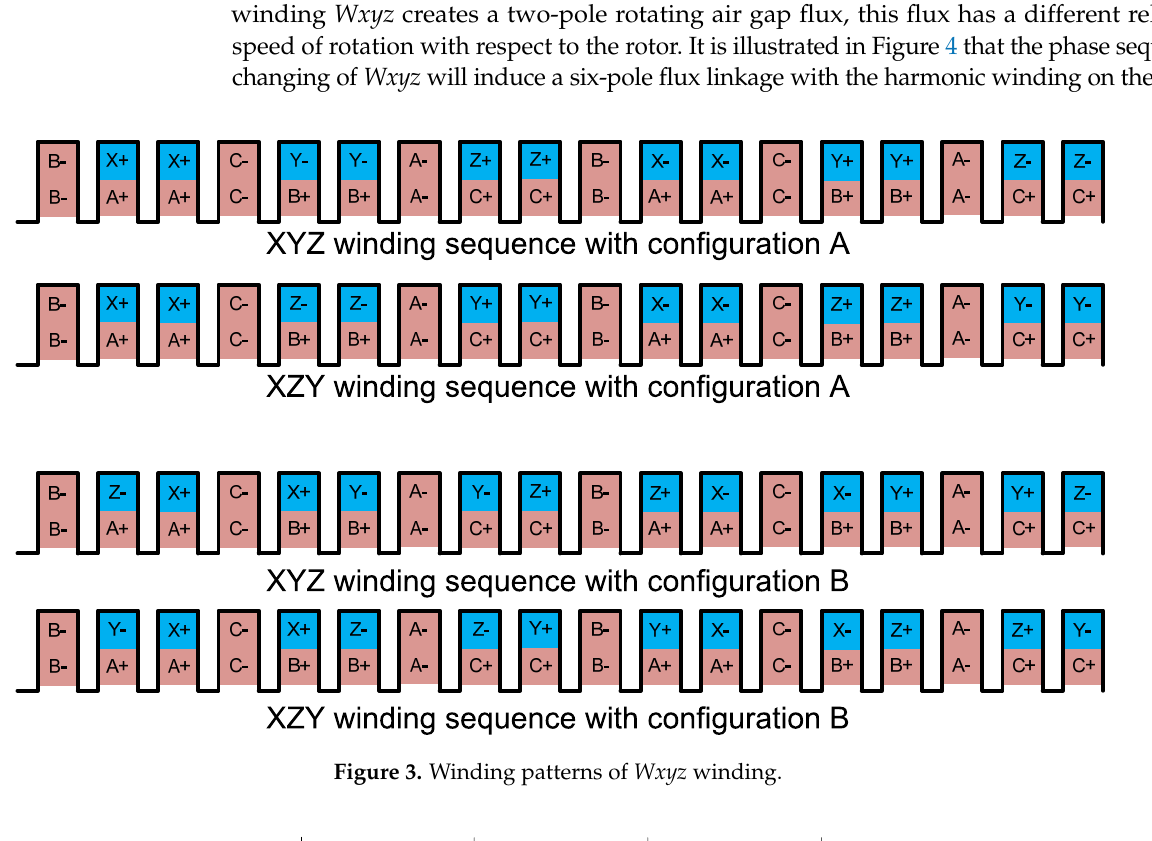
Figure 3. Winding patterns of Wxyz winding.